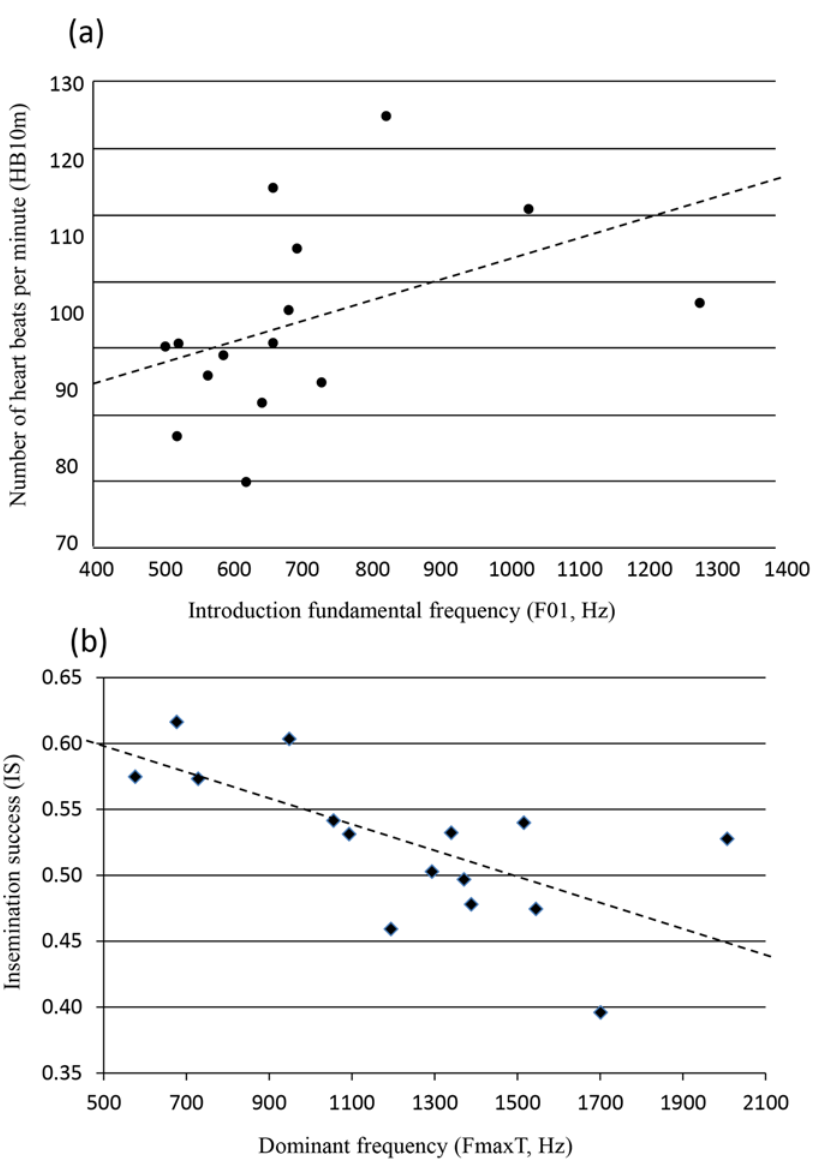
Fig 2. Correlation between voice frequencies in relation to (a) heart beat rates (P = 0.03) and (b) fertility scores (P =